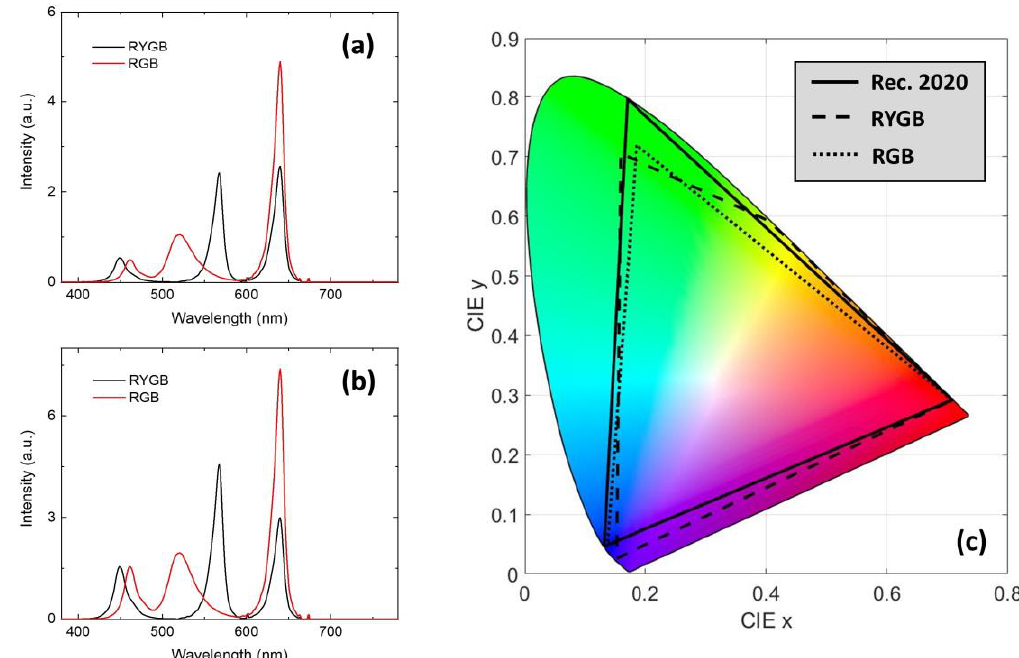
Figure 8. The spectra of an optimal RGB-type and an optimal RYGB-type micro-LED displays for ( a ) the 3000 K white point and ( b ) the 4000 K white point, as well as ( c ) the corresponding color gamut of these two displays in International Commission on Illumination (CIE) 1931 color space. Table 2. Comparison of the circadian illuminance for di ff erent